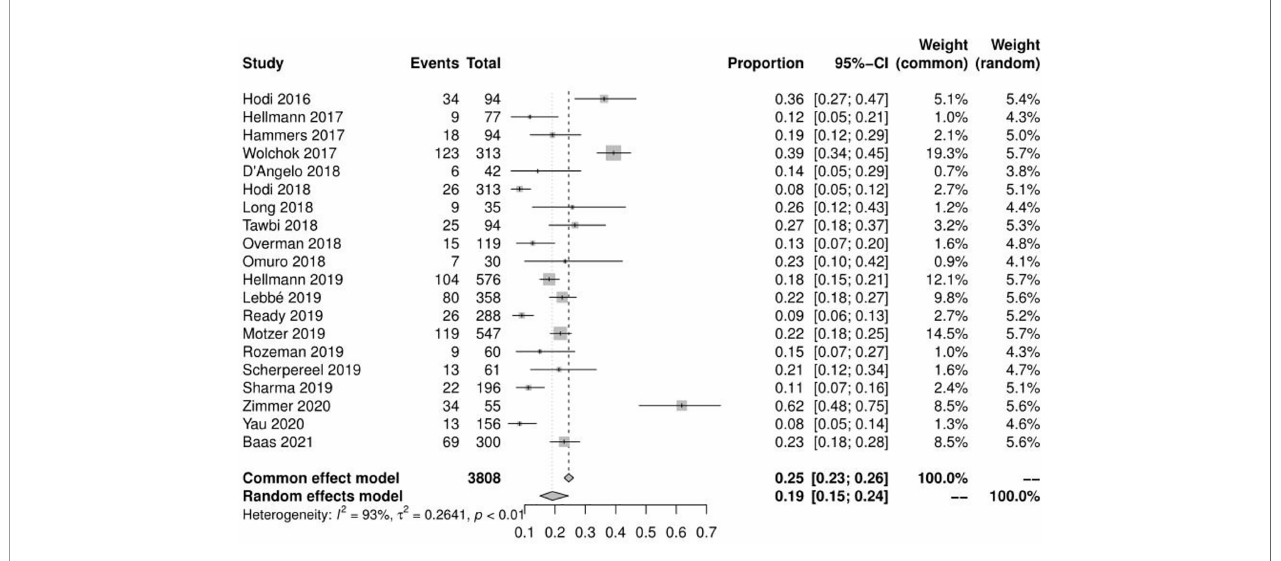
FIGURE 5 | Forest plot of adverse events leading to